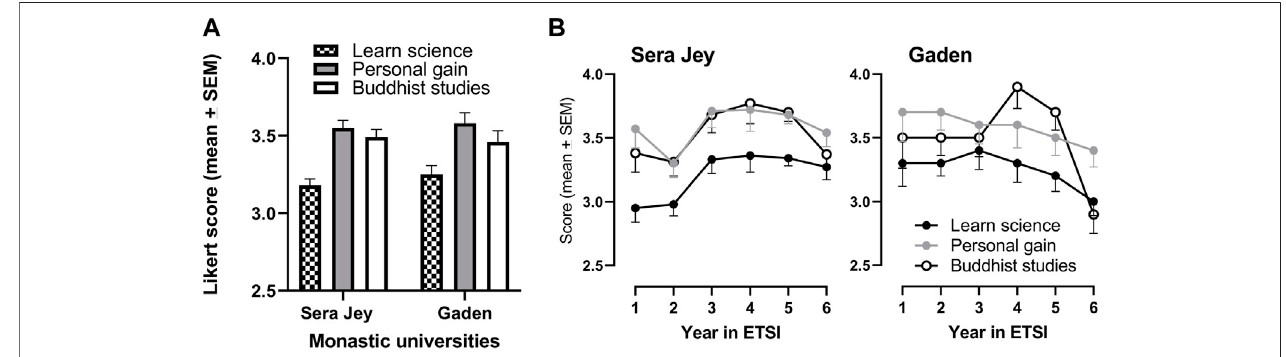
FIGURE 3 | Monastic students ’ perceptions on bene fi ts of learning science at Sera Jey and Gaden Monastic Universities (2019 study) (A) At Sera Jey and Gaden monasteries, monastic students rated learning science content as a bene fi t of participation signi fi cantly lower on a Likert-type scale of 1-5 compared with personal monastic gain or bene fi ts to their Buddhist studies, p < 0.0001 and p (cid:1) 0.0003 for Sera Jey and Gaden, respectively. (B) At Sera Jey and Gaden monasteries, all perceived bene fi ts increased as students responded from Year 1 to Year 4, and Likert scores began to decline for the Year 5 and 6 students. Each different circle style is representative of different perceived bene fi ts of learning